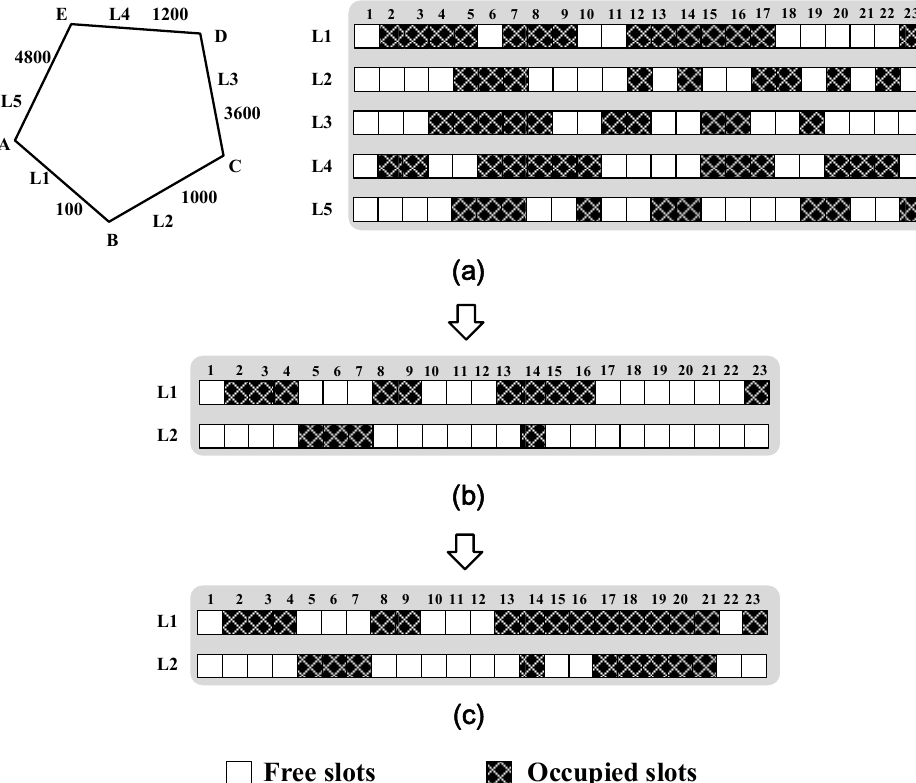
Figure 1. An illustrative example for the proposed Advanced-Reservation-based Invalid-Spectrum-Aware (AR-ISA) algorithm. ( a ) The network topology employed and the usage of all frequency slots (FSs) at a certain time, ( b ) after FSs are released on links L1 and L2, ( c ) available FSs on links L1 and L2 found for the